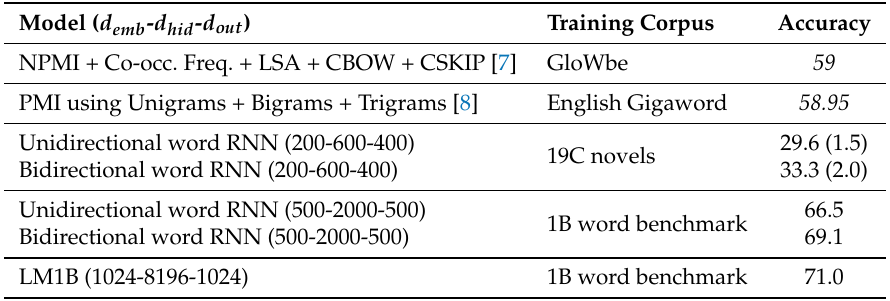
Table 6. Accuracy results (%) for the SAT set. The accuracies in italic were copied from their corresponding publications. We report the average accuracy with the standard deviation if a model was optimized repeatedly.